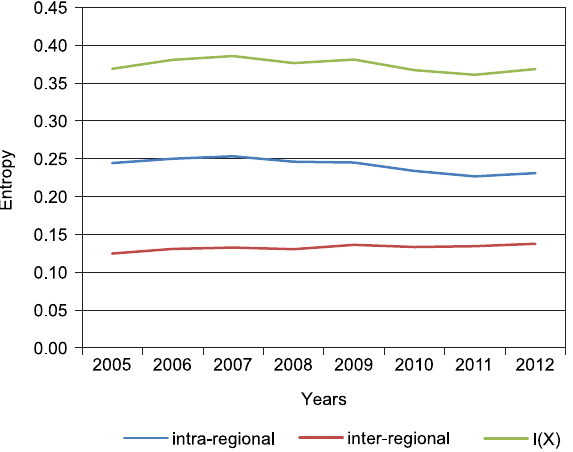
Fig. 2. Inequality in Poland on the scale of income generated in the years 2005–2012 on the basis of the entropy measure of